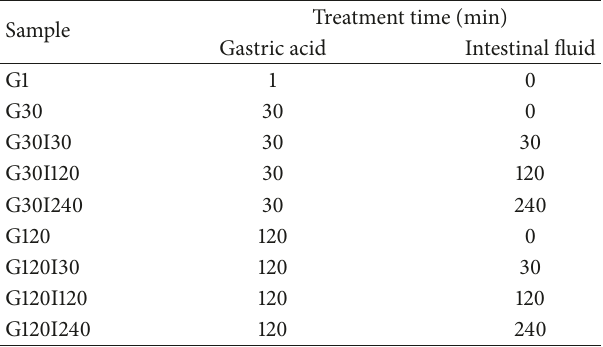
Table 2: Digestion challenge model treatments ∗ . Sample